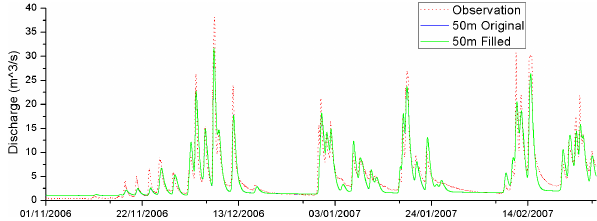
Fig. 14. Whole catchment flow simulations using 200m resolution DEM in MIKE